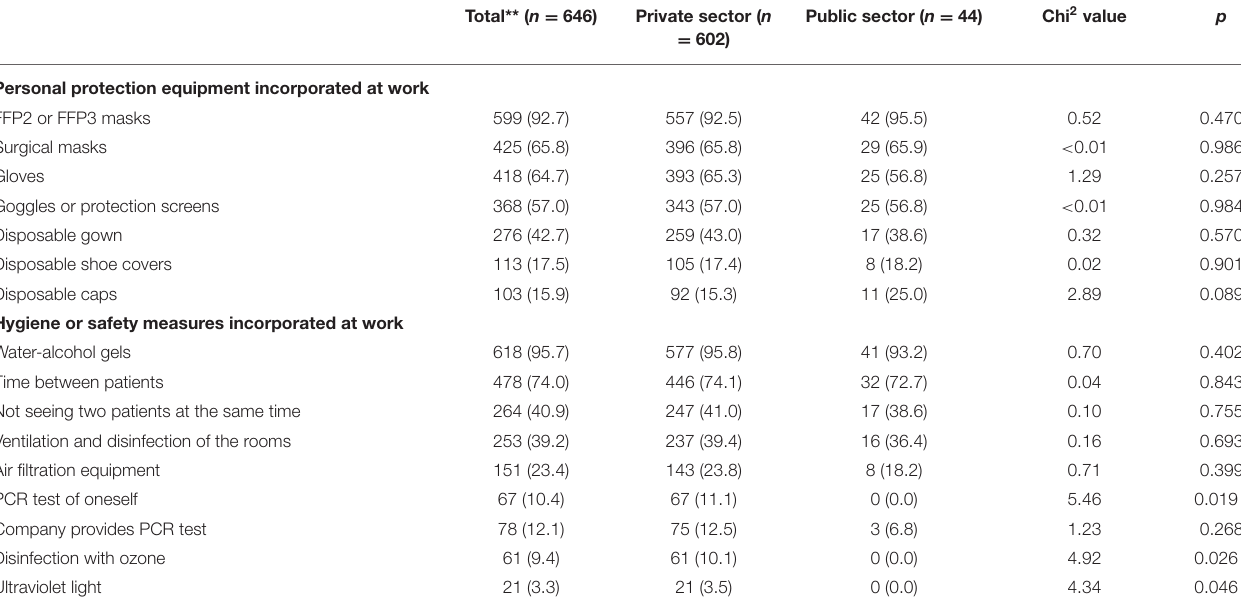
TABLE 2 | Personal protection equipment, hygiene measures, and safety measures incorporated at work during the pandemic by the physical